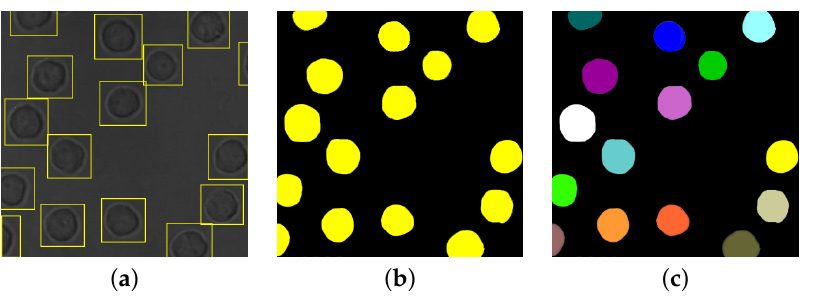
Figure 2. Results of different image processing tasks: ( a ) cell detection; ( b ) cell semantic segmentation; ( c ) cell instance